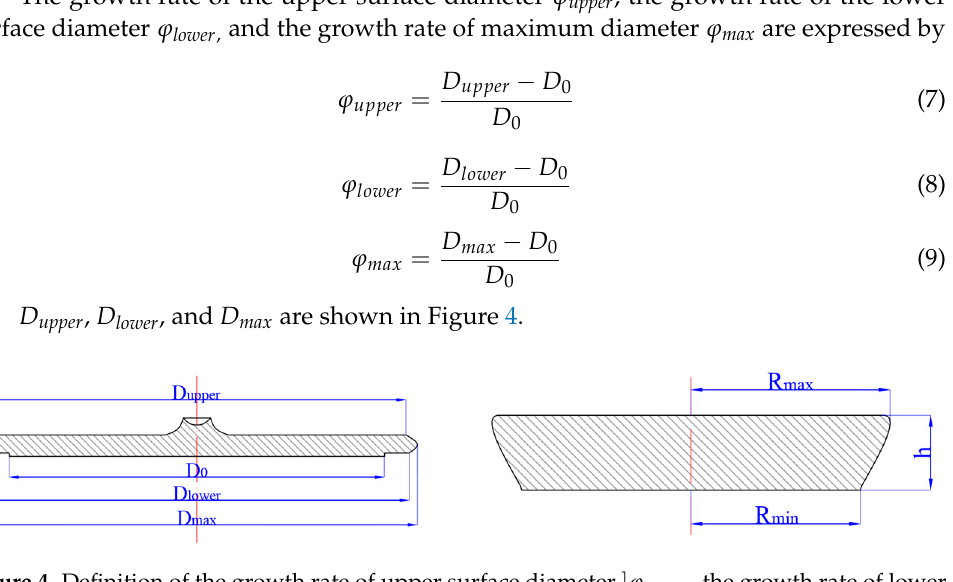
Figure 4. Definition of the growth rate of upper surface diameter φ upper , the growth rate of lower surface diameter φ lower , the growth rate of maximum diameter φ max , and the extent of local flow at different heights L f.